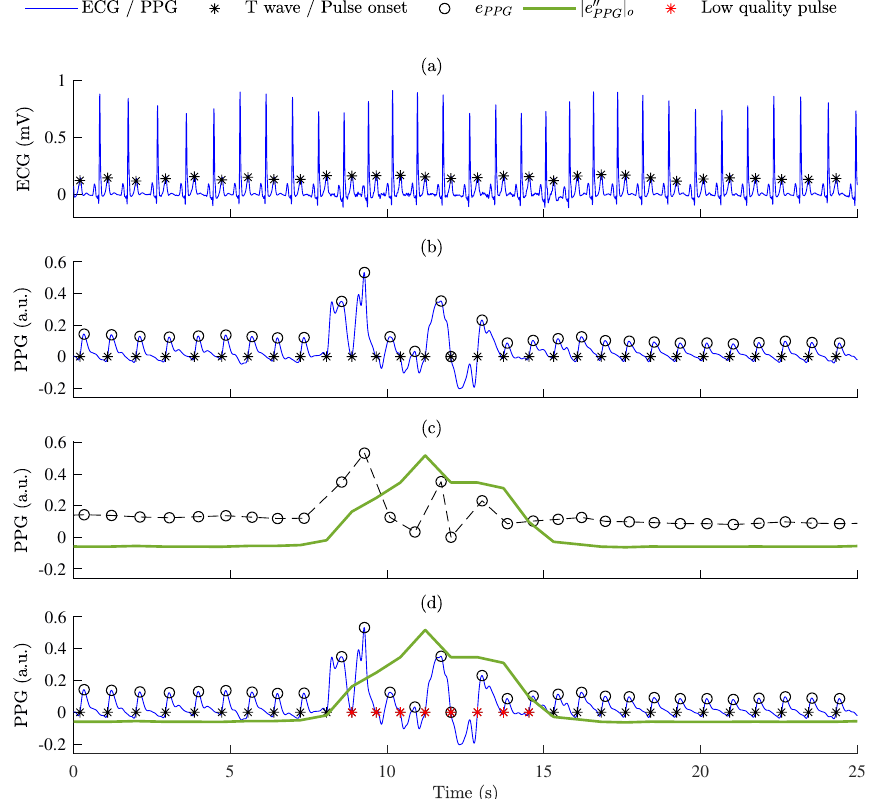
Figure 4. The segmentation of low-quality PPG pulse waves: ( a ) ECG signal with detected T waves; ( b ) PPG signal with detected pulse onsets and estimated maximum values of the PPG signal envelope, e PPG (black circles); ( c ) the second derivative of the PPG signal envelope after offsetting, | e ” PPG | o (shown in green) was calculated from the PPG signal envelope, e PPG (black circles); ( d ) the identification of low-quality pulses according to thresholds θ 1 and θ 2 (red stars indicate low- quality